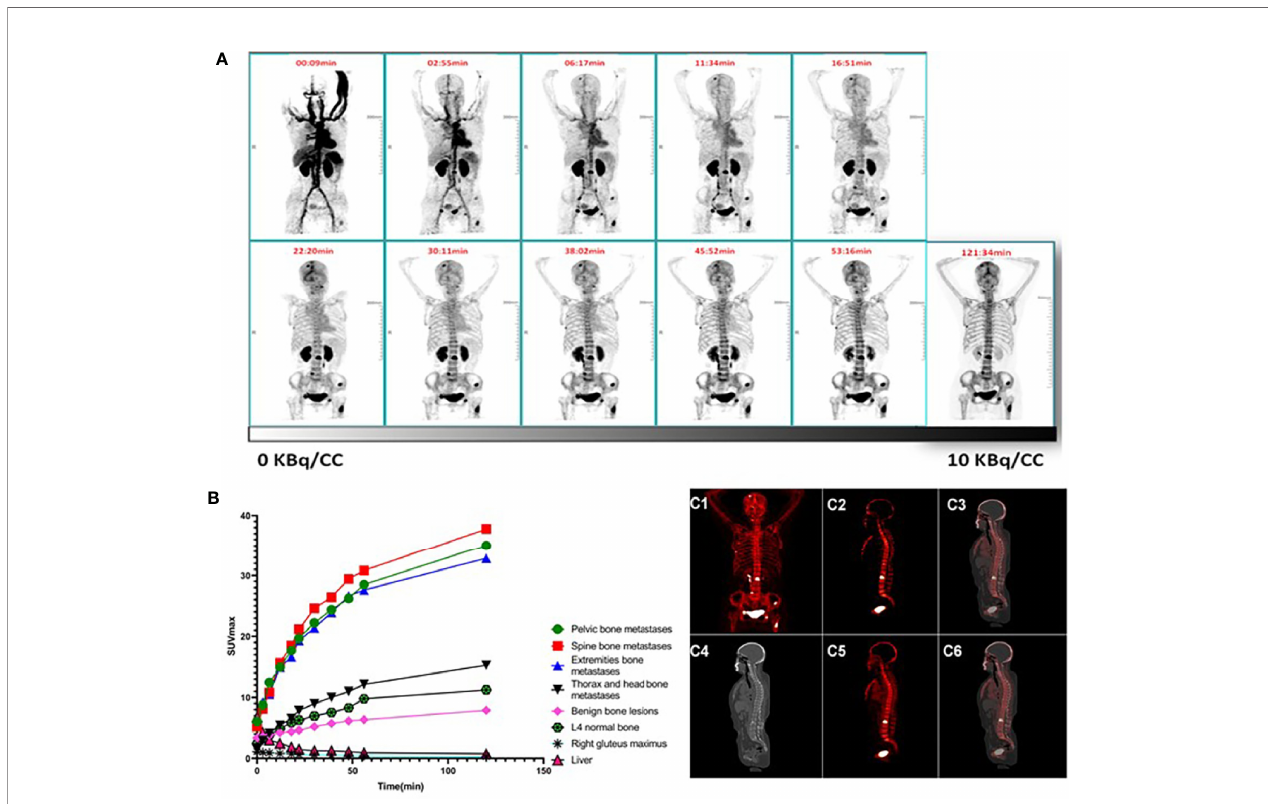
FIGURE 1 | (A – C) Pharmacokinetics of 68 Ga-P15-04.1 (A) Dynamic Maximum-intensity projections (MIP) of patient #3 who received 220.5 MBq 68 Ga-P15-041. Top row indicates starting time (min) of whole-body scan. (B) Kinetic curves for SUVmax of different sites and lesions with time. Rapid uptake in bone lesions suggest that optimal images may be obtained at early time points. (C) Patlak maps and static SUV image of a representative patient (Same patient as in panel A ). (C1, C2) The MIP and a sagittal slice of the Patlak map; (C3) the merged image of the Patlak map and CT; (C4) the corresponding sagittal CT slice; (C5, C6) the corresponding sagittal slice of the routine PET and fused